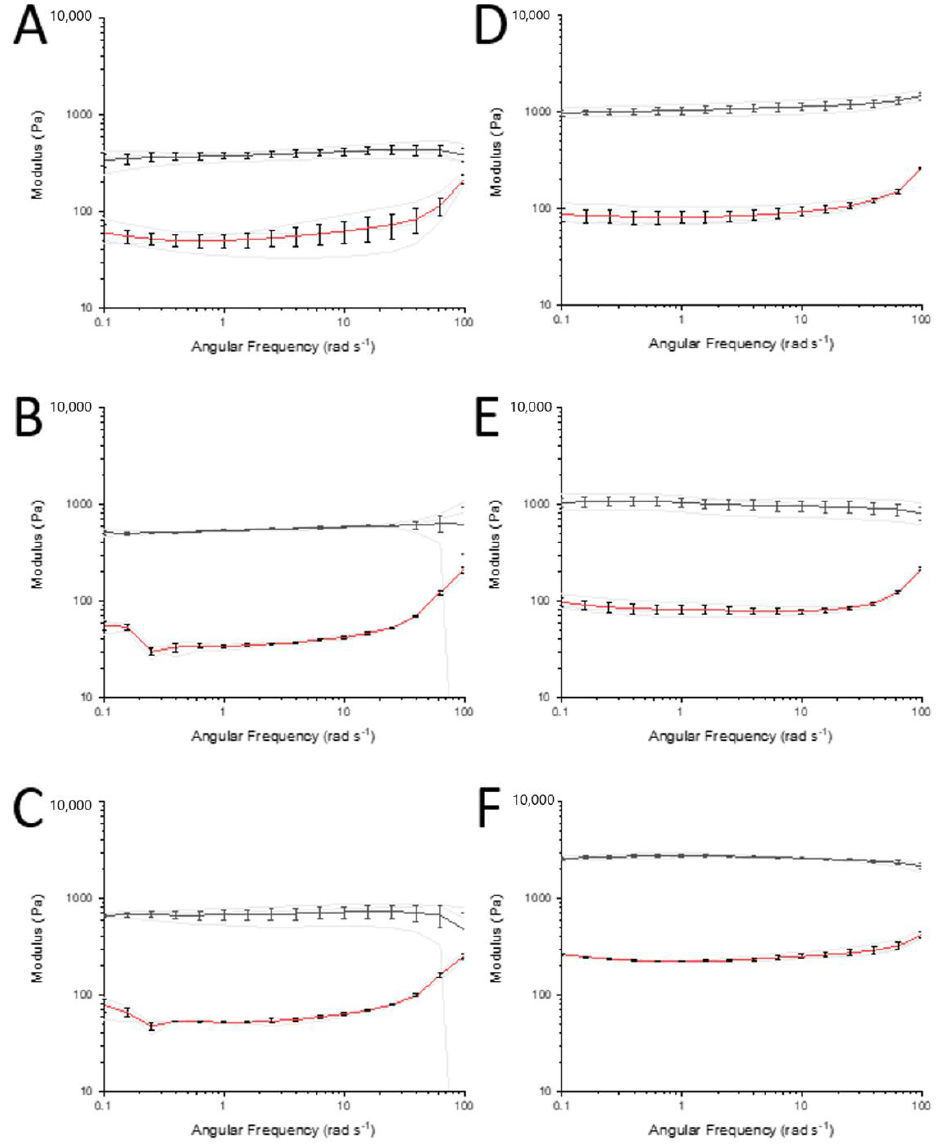
Figure 5. Mechanical properties in shear of collagen-GMA hydrogel at varying weight percent (wt.%). Frequency sweeps show collagen-GMA hydrogel at ( A ) 0.8, ( B ) 0.9, ( C ) 1.0, ( D ) 1.1, ( E ) 1.2 and ( F ) 1.6 wt.%. The black and red lines show the mean storage and loss modulus for each experimental group (±SE), respectively. Grey lines depict actual measurements. All samples had a higher storage modulus compared to loss modulus, indicating hydrogels were behaving as viscoelastic solids. As weight percent of collagen-GMA hydrogels increased, storage modulus also increased. n = 3.